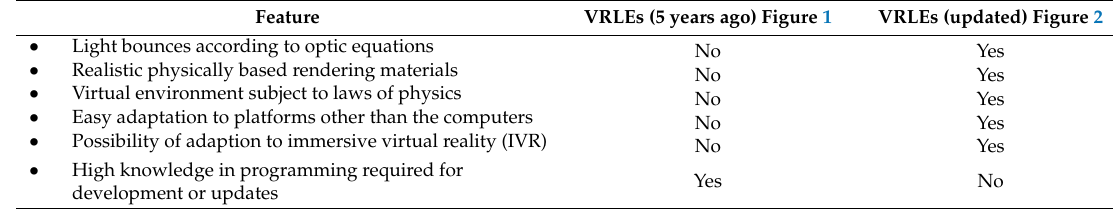
Table 1. Comparison of main characteristics of VRLEs developed by the authors at di ff erent stages.